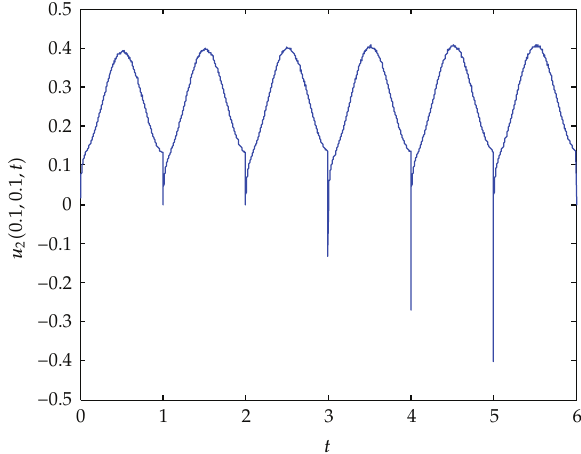
Figure 6: The curve of u 2 (cid:3) t, 0 . 1 , 0 . 1 (cid:4) when x 1 (cid:8) 0 . 1, x 2 (cid:8) 0 .